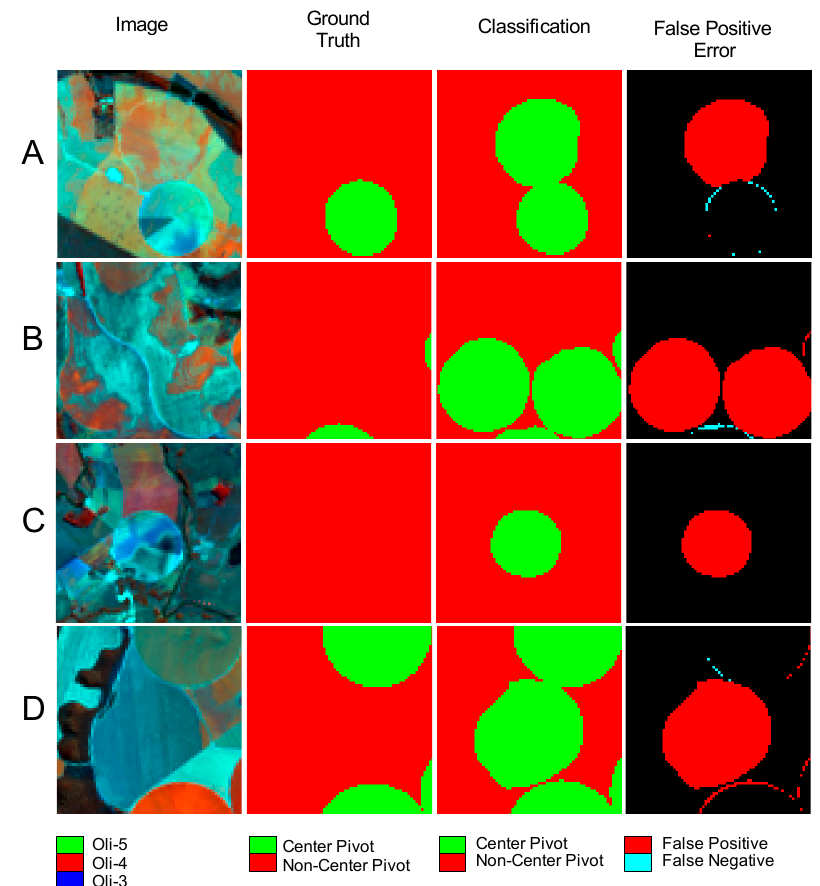
Figure 14. Examples of false negatives ( A – D ) using the U-net, where detected central pivots do not correspond to terrestrial truth.